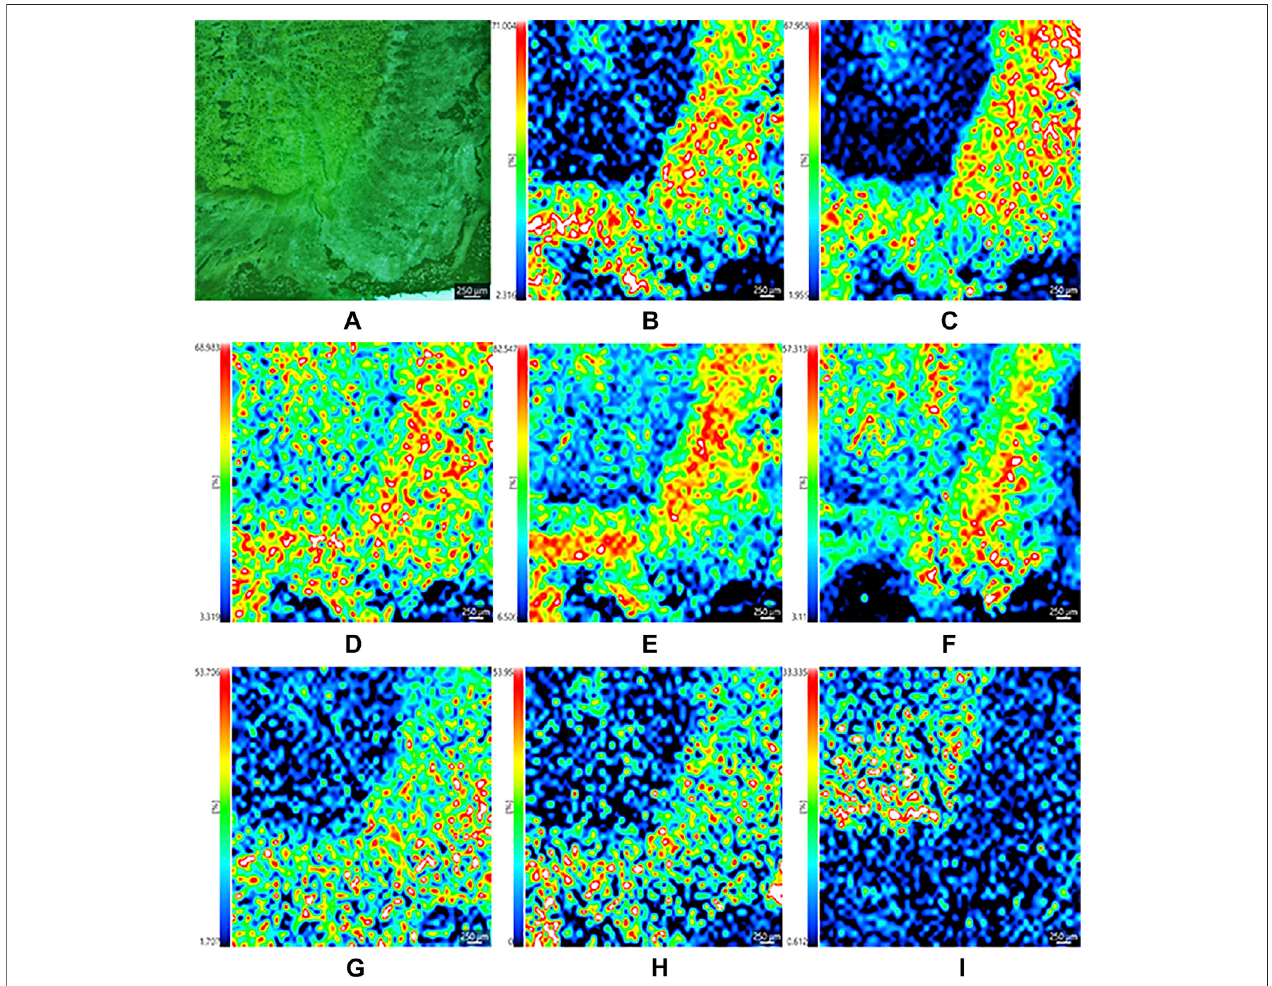
FIGURE4| Opticalimageofthedriedrootof Isatisindigotica (A) ,andthemassspectrometryimagesofthenegativeionsofisatindigosideF (B) ,clemastaninB (C) , maleic acid (D) , malic acid (E) , citric acid (F) , sucrose (G) , isovitexin (H) , and vanillin (I) .